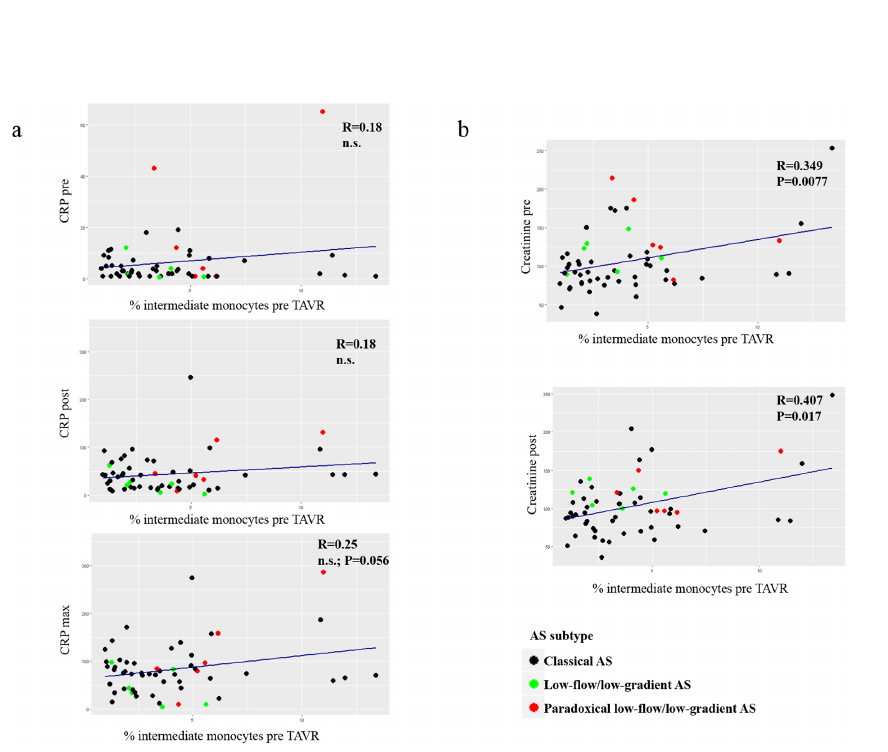
Fig 4. Correlations of intermediate monocytes with CRP and creatinine. (a) Correlations between intermediate monocytesmeasuredby flow cytometry with serum CRP levels [mg/l] before and at day 4–7 after TAVR-procedureas well as intermediate monocytes before with maximum CRP-levelbetweenTAVR procedure and day 4–7. (b) Correlationsbetweenintermediatemonocytes and creatinine-levels( μ mol/l) before and early after